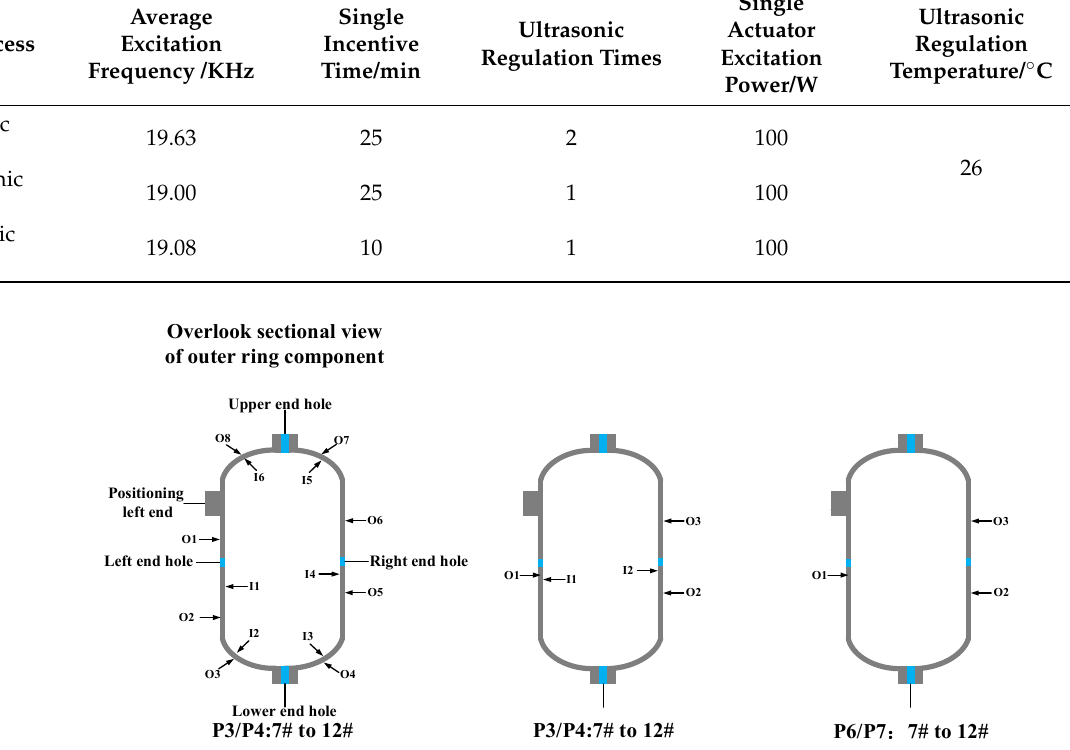
Figure 7. Schematic diagram of residual stress detection points under USR treatment. The average residual stresses (ARS) of components (from 7# to 12#) after different processes are shown in Figure 8. The stress distribution trends of the six components are roughly the same. In the forming process, the maximum residual tensile stress distribution is introduced when the components cutting frame from the round billet. Except for 10# and 11#, the residual stresses of other components after rough milling are larger than those after wire cutting. Figure 8. Average residual stress distribution of 7# to 12#. The stress distribution of components 7# to 12# formed by various processing pro- cesses is basically the same. Component 7# is selected to analyze the distribution of resid- ual stress and the corresponding deformation law after different processing processes, as shown in Figure 9a. After the removal materials of P1/P3/P5, the stress values at each de- tection point fluctuated greatly compared with the average stress value. Three ultrasonic destressing treatments can significantly reduce the residual stress peak value, and the stress value of the component in state of low stress distribution will also decrease after the subsequent processing. The dimensional deformation measurement of the components is shown in Figure 9b. Along with the decrease in residual stress, the changes in M1 (distance between left and right end of inner part) and M2 (distance between upper and lower end of inner part) and the radius of upper and lower circles (M3–M6) are not consistent. The wire cutting blank and the first stress removal did not drill holes in the component. The angle of vertical line between left and right face and upper and lower face is regarded as